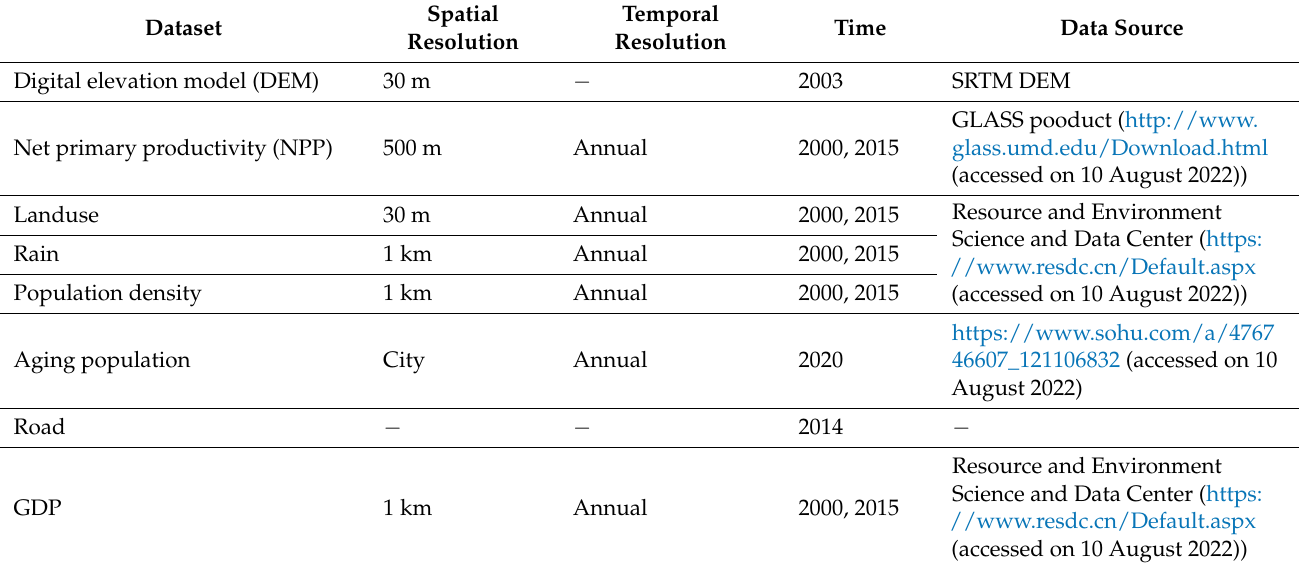
Table 2. Datasets used in the construction of the index system.